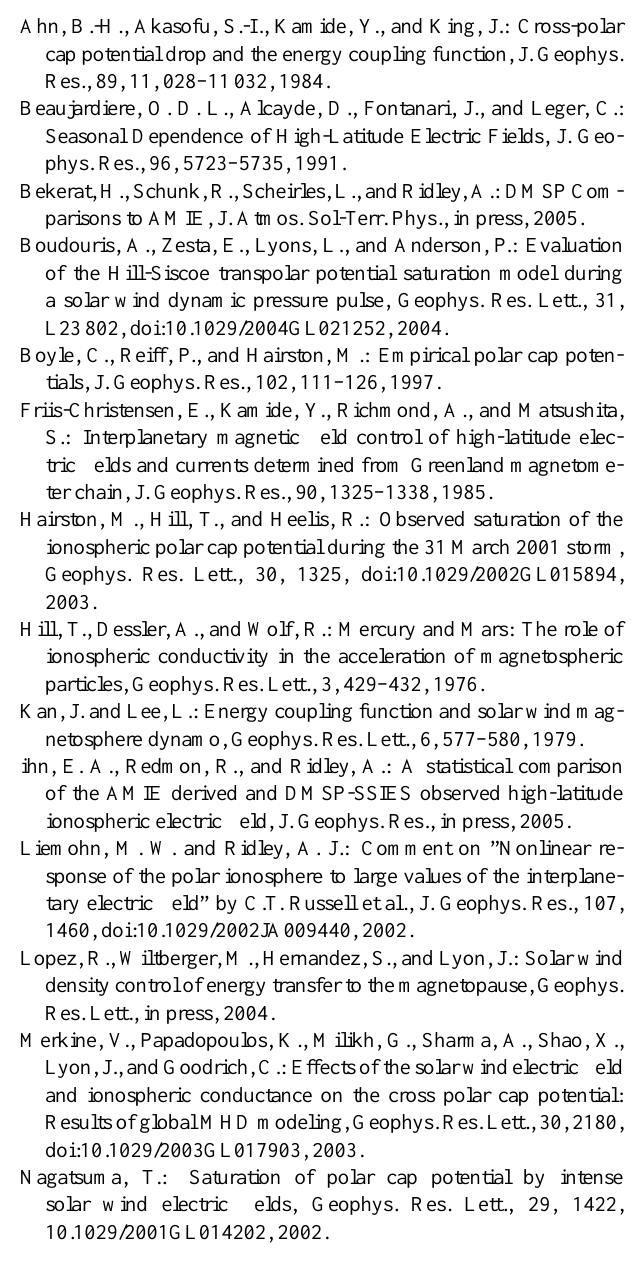
Fig. 18. May 11-12, 1999, in the same format as Figure 9. Fig. 18. May 11–12, 1999, in the same format as Fig. 9.